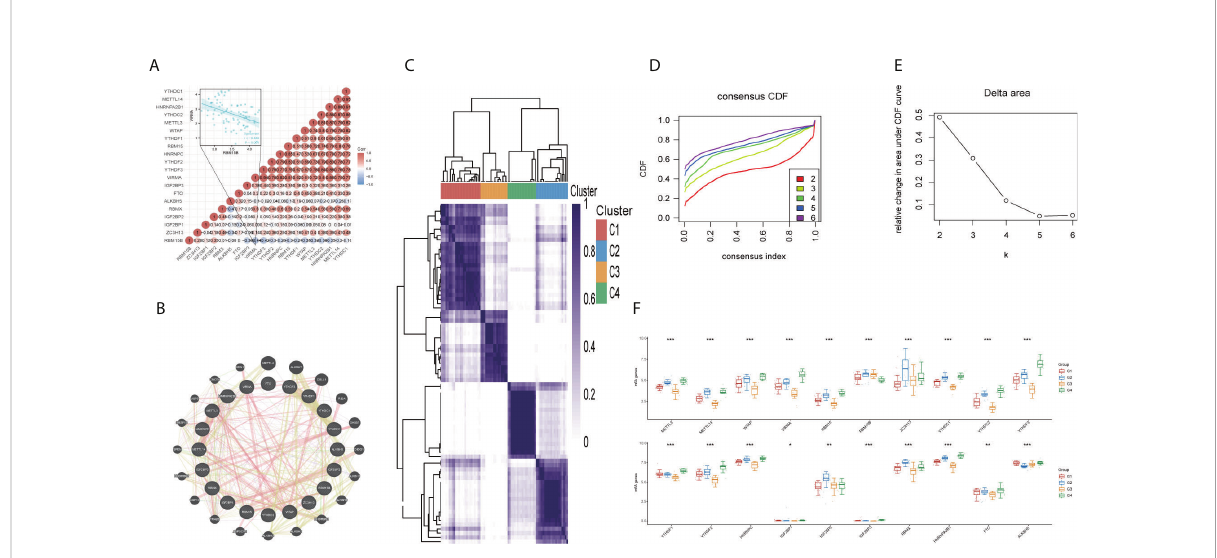
FIGURE 1 Correlations and consensus clustering analysis of 20 m 6 A regulators. (A) Heatmap of the correlation between the 20 m 6 A regulators. Red color represents positive correlation and blue represents negative correlation. (B) Twenty most associated molecules associated with 20 m 6 A regulators. (C) TCGA uveal melanoma cohort was classi fi ed into four clusters. (D) Cumulative distribution function (CDF) curve and (E) Delta area curve of consensus clustering. (F) Comparison of gene expression levels of 20 m 6 A regulators among four groups. *p<0.05, **p<0.01,